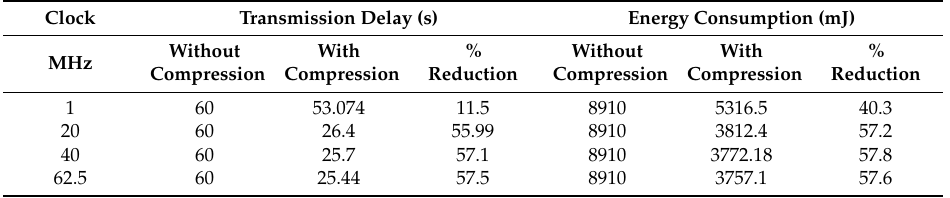
Table 6. Energy and delay reduction for ECG_UoP using shimmer bluetooth nodes.